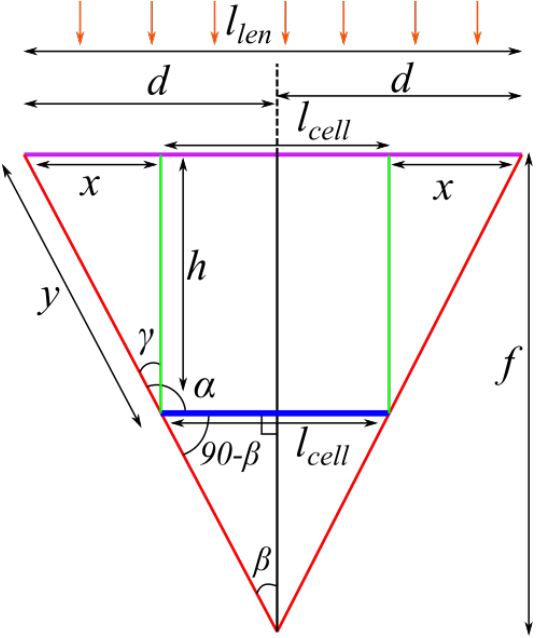
Figure 2. Determining the optimal position of the lens relative to the solar cell.